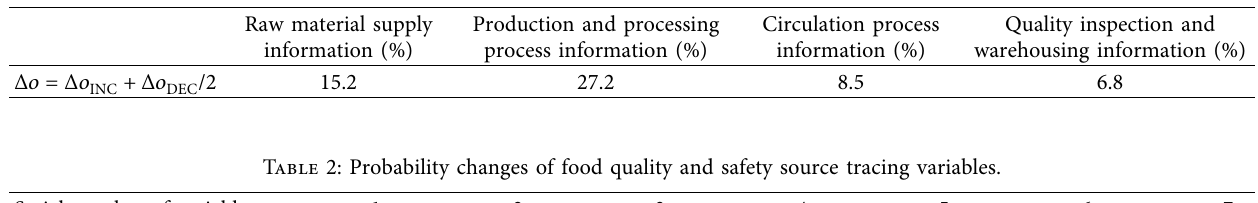
Figure 10: Distribution of tracing time under different numbers of production and circulation Table 1: Probability changes of food quality and safety source tracing variables.